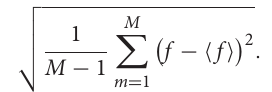
Frontiers in Marine Science |